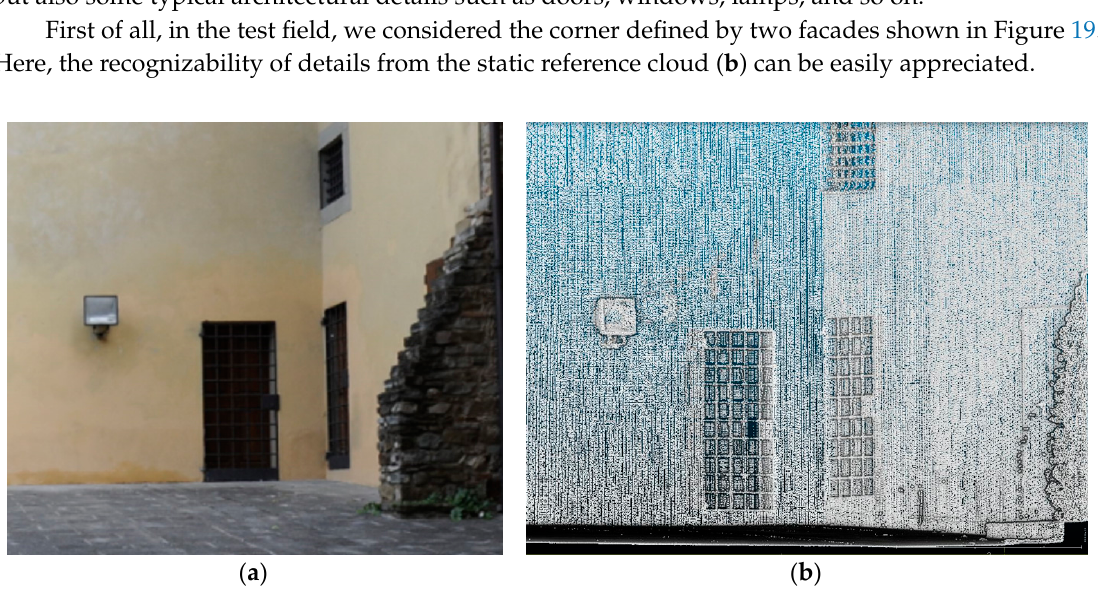
Figure 19. Corner of the chosen building for assessing the recognizability of architectural details; ( a ) photo; ( b ) reference dataset statically acquired by terrestrial laser scanning (TLS) and down-sampled with 1-cm average resolution.